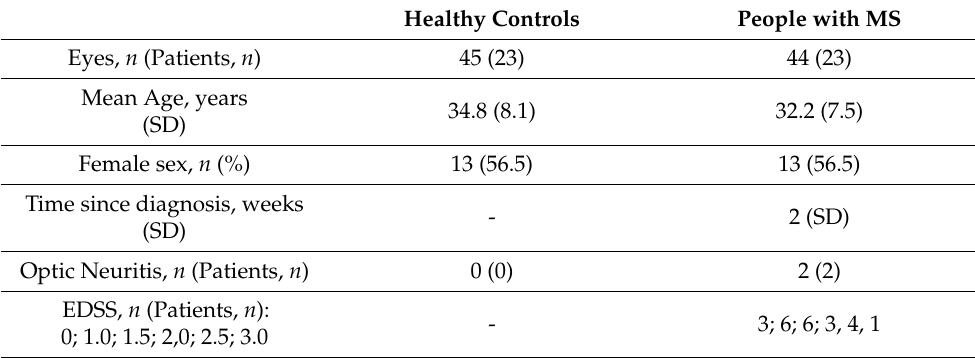
Table 1. Subject demographics and study group characteristics.